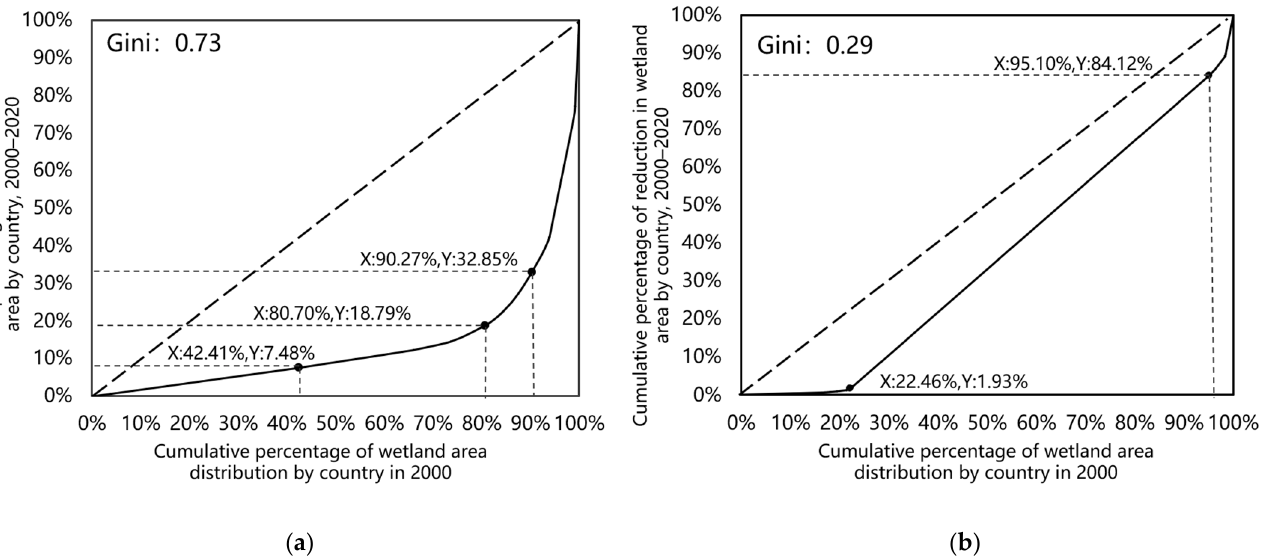
Figure 10. Lorenz curves representing the equality of wetland area changes from 2000 to 2020. ( a ). Lorenz curve for the area increase. ( b ). Lorenz curve for the area decrease.